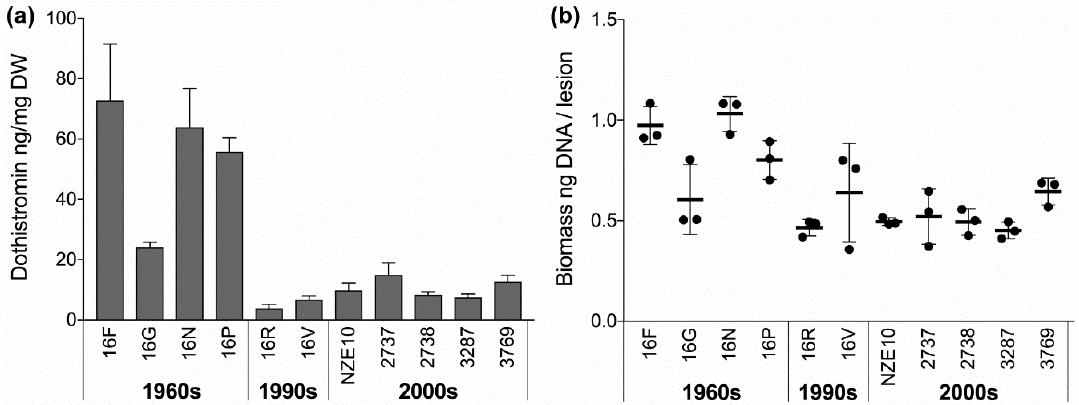
Figure 2. Dothistromin production and virulence assessments of Dothistroma septosporum isolates. ( a ) Levels of dothistromin produced in culture by the ten re-sequenced D. septosporum isolates, as well as the reference isolate NZE10. Values are normalised by dry weight of fungal biomass and shown as mean and SD of three biological replicates. Nested ANOVA and e ff ect size analysis showed a significant e ff ect of decade group on dothistromin levels ( p = 0.002, ω 2 = 0.74). ( b ) Virulence assessment of the same set of isolates of D. septosporum shown as relative fungal biomass per disease lesion on Pinus radiata needles. Biomass was determined by qPCR by its proxy, D. septosporum DNA levels, and is shown with mean and SD of three biological replicates. Nested ANOVA and e ff ect size analysis showed a significant e ff ect of decade group on biomass levels ( p = 0.016, ω 2 = 0.50).